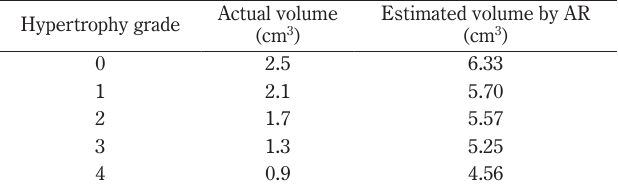
Figure 7. Quantitative analysis by an accompanying software with AR showed that the actual volumes of the models of simulated inferior nasal turbinate hypertrophy were 0.4 cm 3 and 0.8 cm 3 , corresponding with AR estimates of 0.5 cm 3 and 0.91 cm 3 , respectively. These differences between actual and estimated volumes were minor. The actual and estimated volumes of the simulated adenoid hypertorophy and of the nasopharyngeal lumen are shown in Tables 1 and 2, respectively. For each grade of adenoid hypertrophy, the estimated and actual adenoid volumes were almost equivalent. However, the estimated airway volumes of the nasopharynx were considerably greater than the actual volumes.